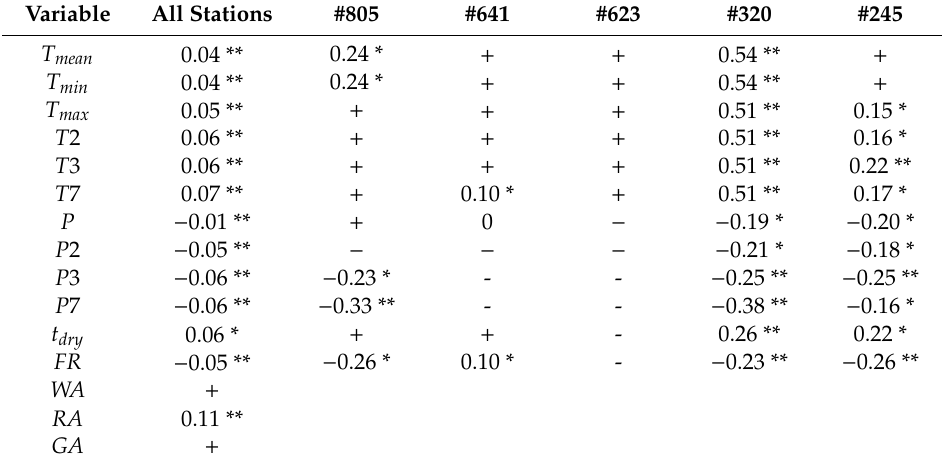
Table 2. Non-parametric correlation Kendall τ -b of Log FC i,j for all stations and at each hot spot. The symbol ‘*’ indicates the numeric value of τ -b has a p -value less than 0.05 and ‘**’ indicates a p -value less than 0.01. Symbols ‘ + ’ and ‘ − ‘ indicate the correlation was positive or negative, respectively, but is not